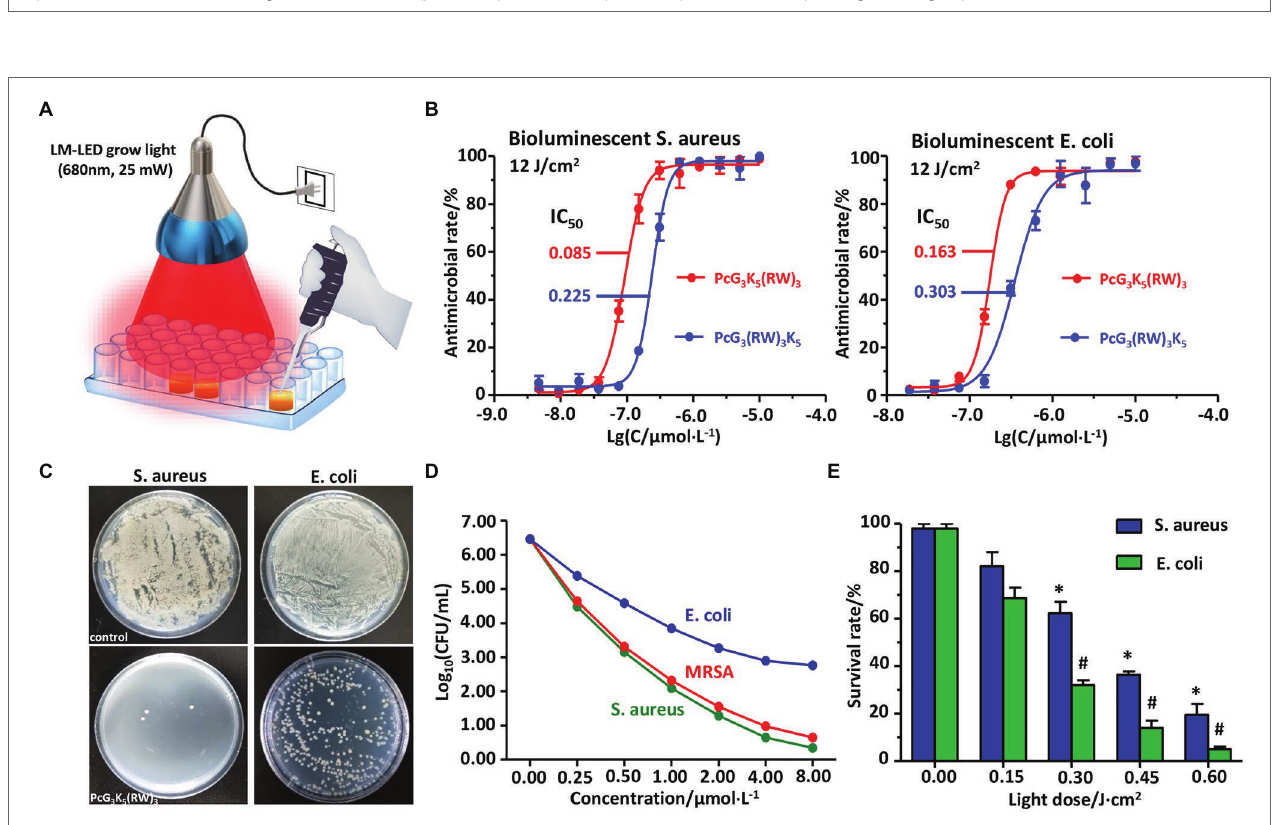
FIGURE 4 | The antimicrobial activity of PcG 3 K 5 (RW) 3 (4) in the presence of light. The efficacy was measured in 96-well microplates under illumination by LM-LED (A) . PcG 3 K 5 (RW) 3 showed higher antimicrobial activity against both bioluminescent S. aureus and bioluminescent E. coli under illumination (light dose of 12 J/cm 2 , 33.33 mW/cm 2 ) at a low concentration (2 μ M) compared to PcG 3 (RW) 3 K 5 (B) . PcG 3 K 5 (RW) 3 induced up to 5-log reduction of S. aureus and 3-log reduction of E. coli under illumination (light dose of 12 J/cm 2 , 33.33 mW/cm 2 ) at a low concentration (2 μ M), which were measured by colony counting method (C) . This peptide also showed similar activity against multiple resistant strains [methicillin-resistant S. aureus (MRSA)] (D) . The result of short illumination indicated that the high light dose was not essential to trigger bacterial cell death (E) . Error bars indicated SD for three replications. * and # indicate significant differences to the controls of S. aureus (light dose = 0) and E. coli (light dose = 0), respectively ( p < 0.05).